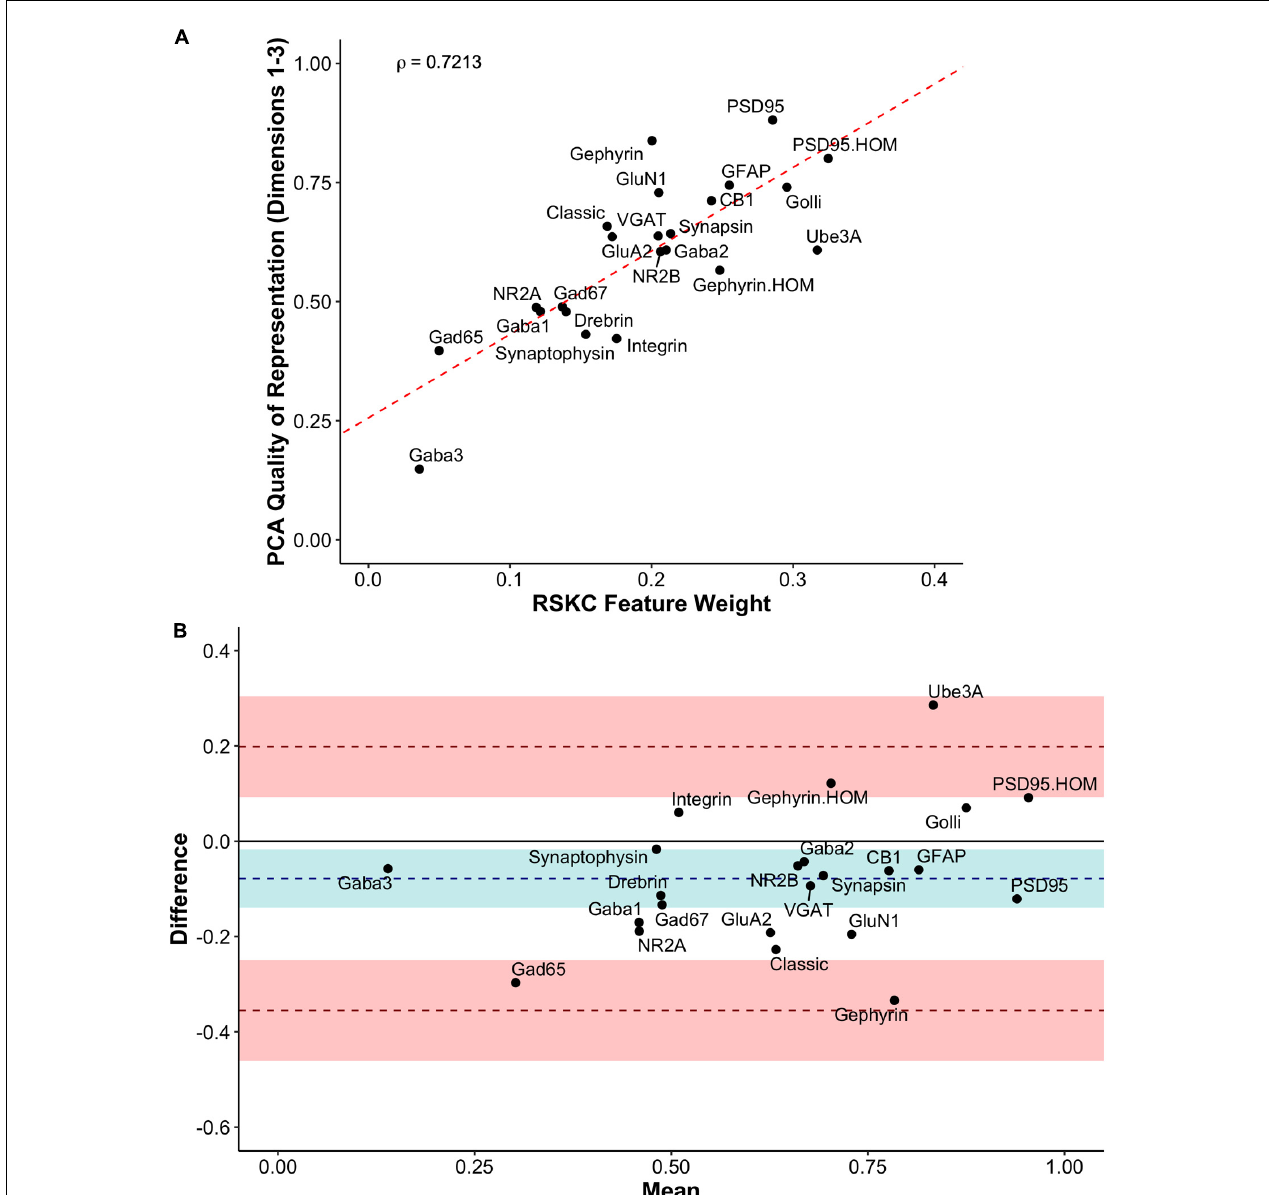
FIGURE 11 | Exploring the relationship between PCA and RSKC feature identification. (A) Scatter plot showing the PCA quality of representation (cos 2 ) for the first three dimensions and the RSKC weights. The dashed line represents the line of best fit, and rho is Spearman’s rank correlation coefficient. (B) Bland–Altman plot comparing PCA cos 2 for the first three dimensions and RSKC weights for 23 proteins. The cos 2 and RSKC weights were each computed as proportions of their respective maximum values. The dashed blue line represents the mean difference, with the 95% confidence intervals shown as the blue shaded area. The top dashed red line represents the upper limit of agreement (+1.96 SD) and the bottom dashed red line is the lower limit of agreement (–1.96 SD), with corresponding 95% confidence intervals shown as red shaded